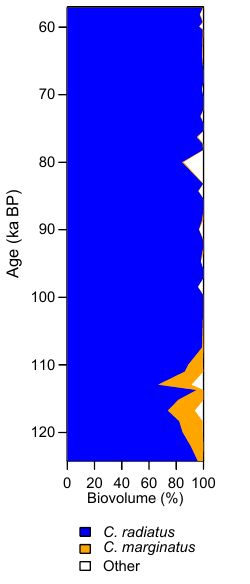
Figure 2. Relative diatom species biovolumes in samples analysed for δ 18 O diatom